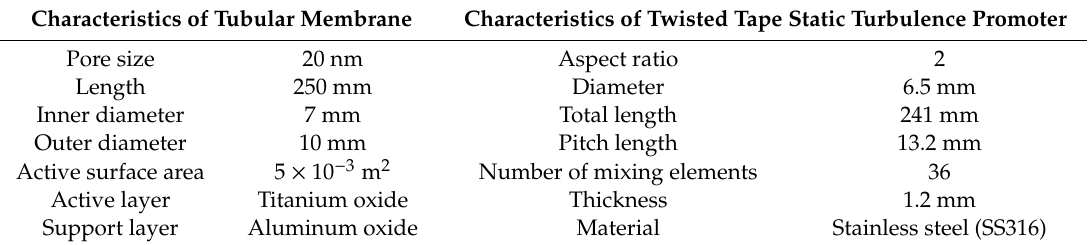
Table 1. Specification of membrane and static turbulence